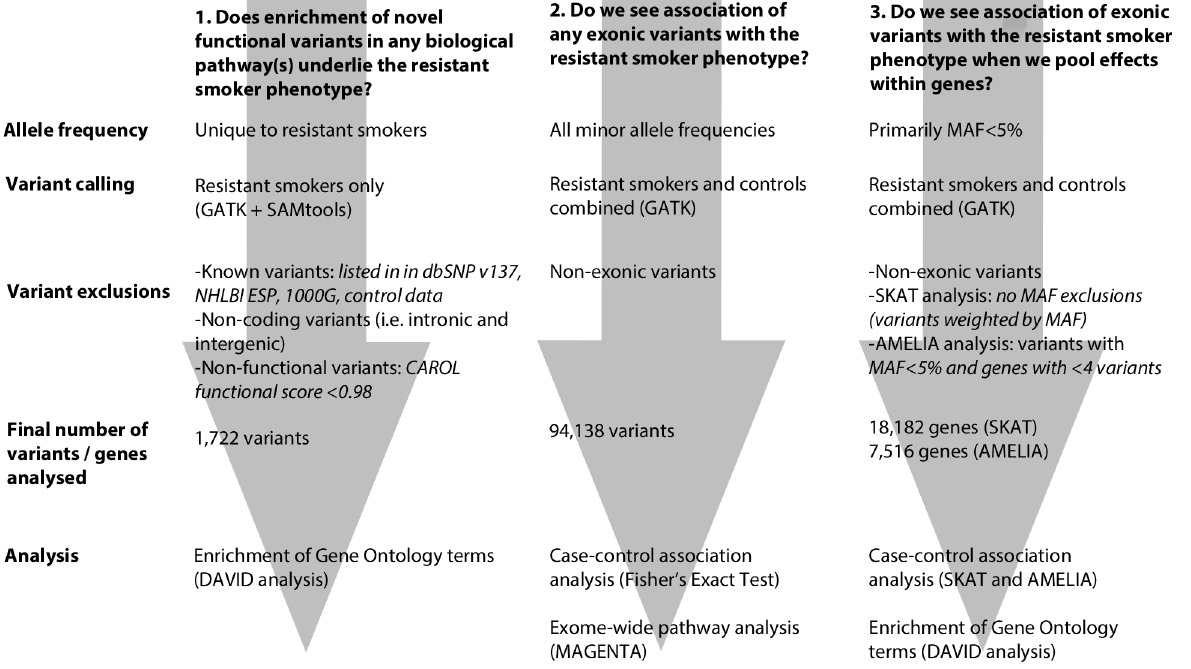
Figure 1. Flowchart describing each of the 3 main analytical pathways used to explore the genetic architecture of smoking resistance. Analyses are described in full in the methods. MAF: minor allele frequency.